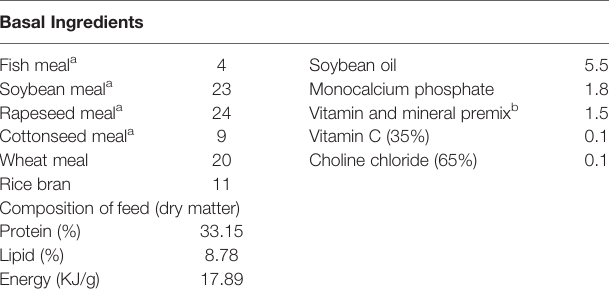
TABLE 1 | Composition of the basal diet (% dry matter).